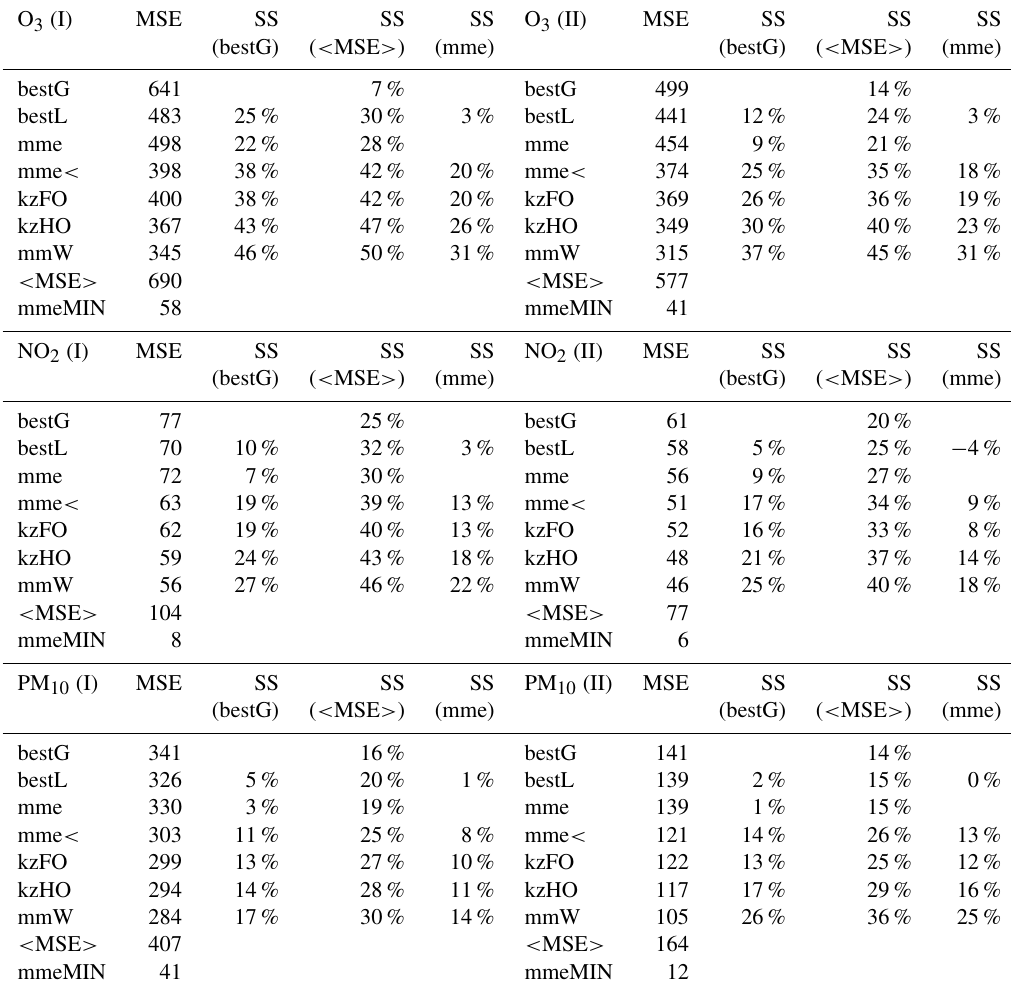
Table 3. The MSE from (a) the best deterministic models globally (bestG) and locally (bestL), (b) the unconditional ensemble mean (mme), and (c) the four conditional ensemble estimators (mme < , kzFO, kzHO, mmW). In addition, the bounds for the MSE of the ensemble mean are also presented. The maximum value ( < MSE > ) arises for ensemble members without diversity and the minimum value (mmeMIN) was estimated from the variance term only (i.e. calculated for unbiased and uncorrelated ensemble members). The ability of the estimators is evaluated through their skill scores (SS REF = 1 − MSE/MSE REF , REF = bestG, < MSE > ,